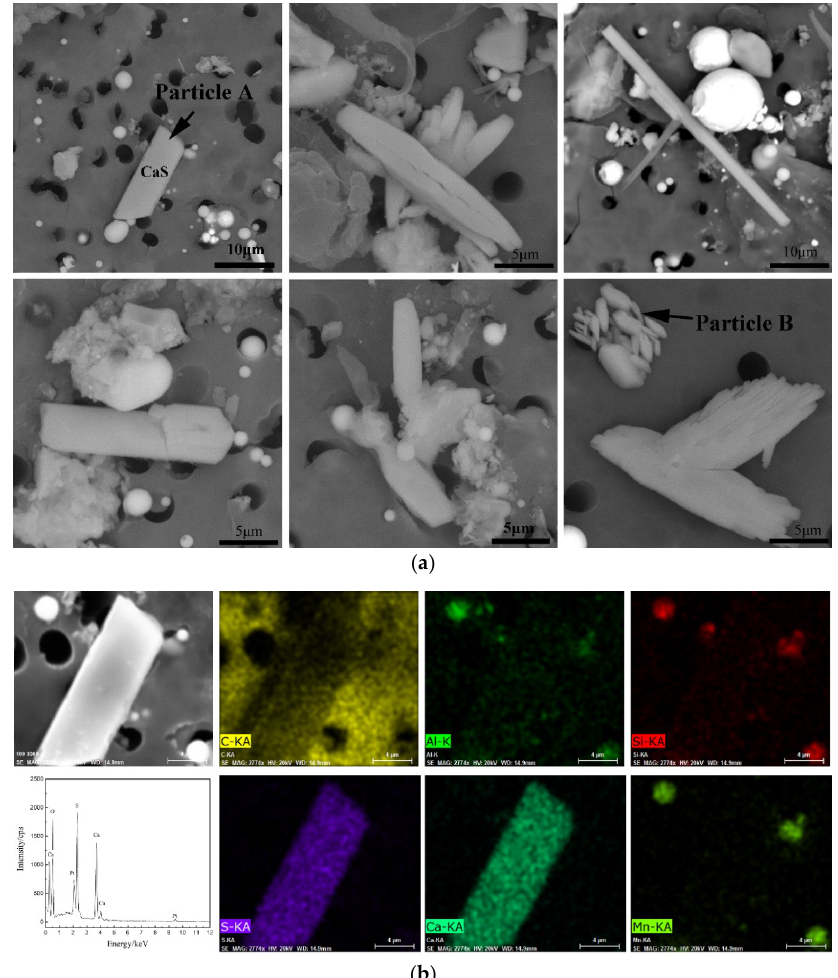
Figure 6. The characteristics following inclusions of CaS under water-cooling conditions. ( a ) The three-dimensional morphology following inclusions of CaS. ( b ) The EDS spectra and mapping of particle B.